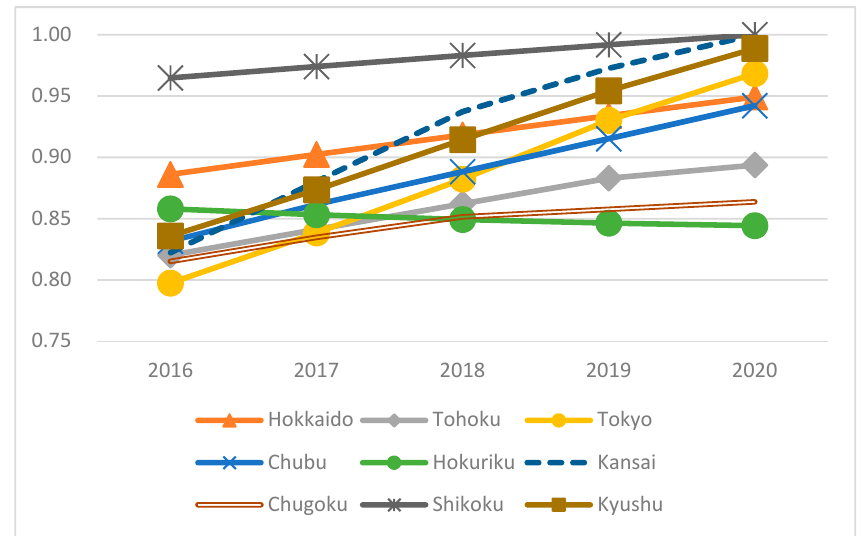
Figure 5. Annual shift of unified e ffi ciencies of electric power companies: Pooled data from 2016